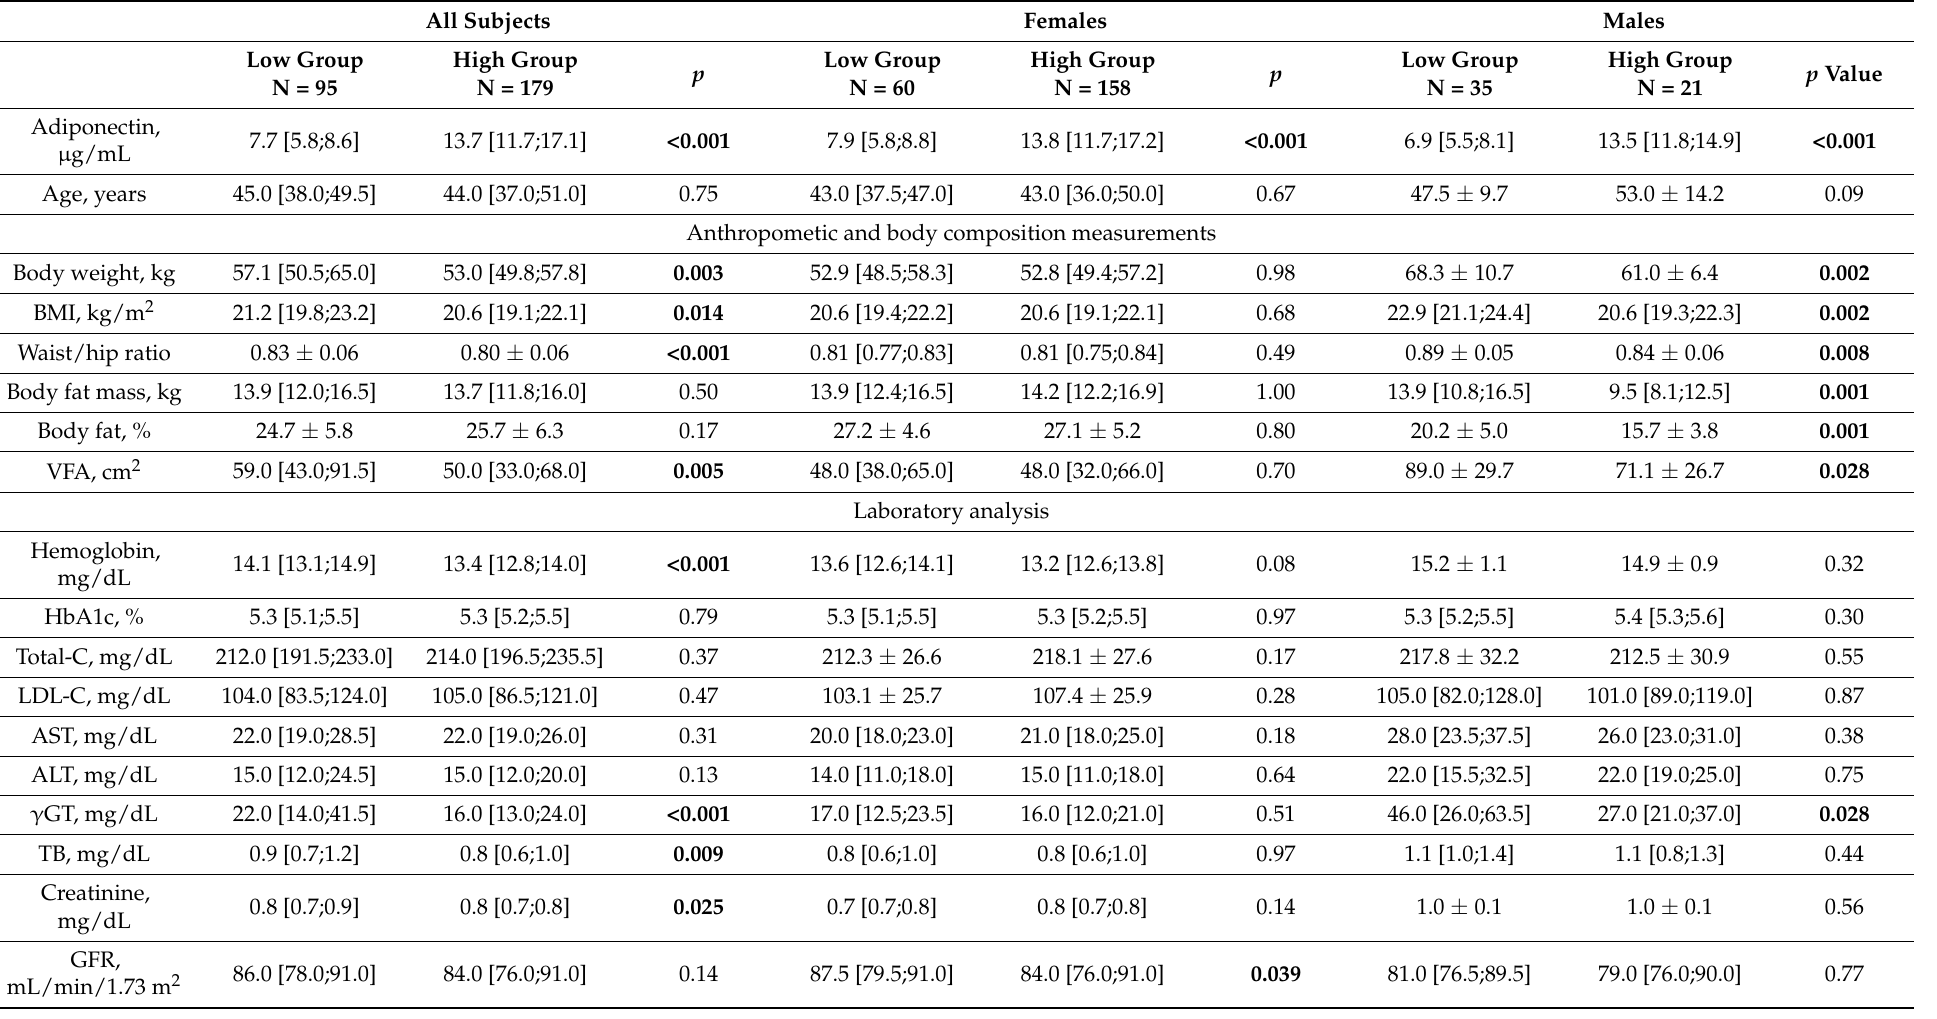
Table 3. Comparison of general health checkup parameters between the low and high serum adiponectin level groups. All